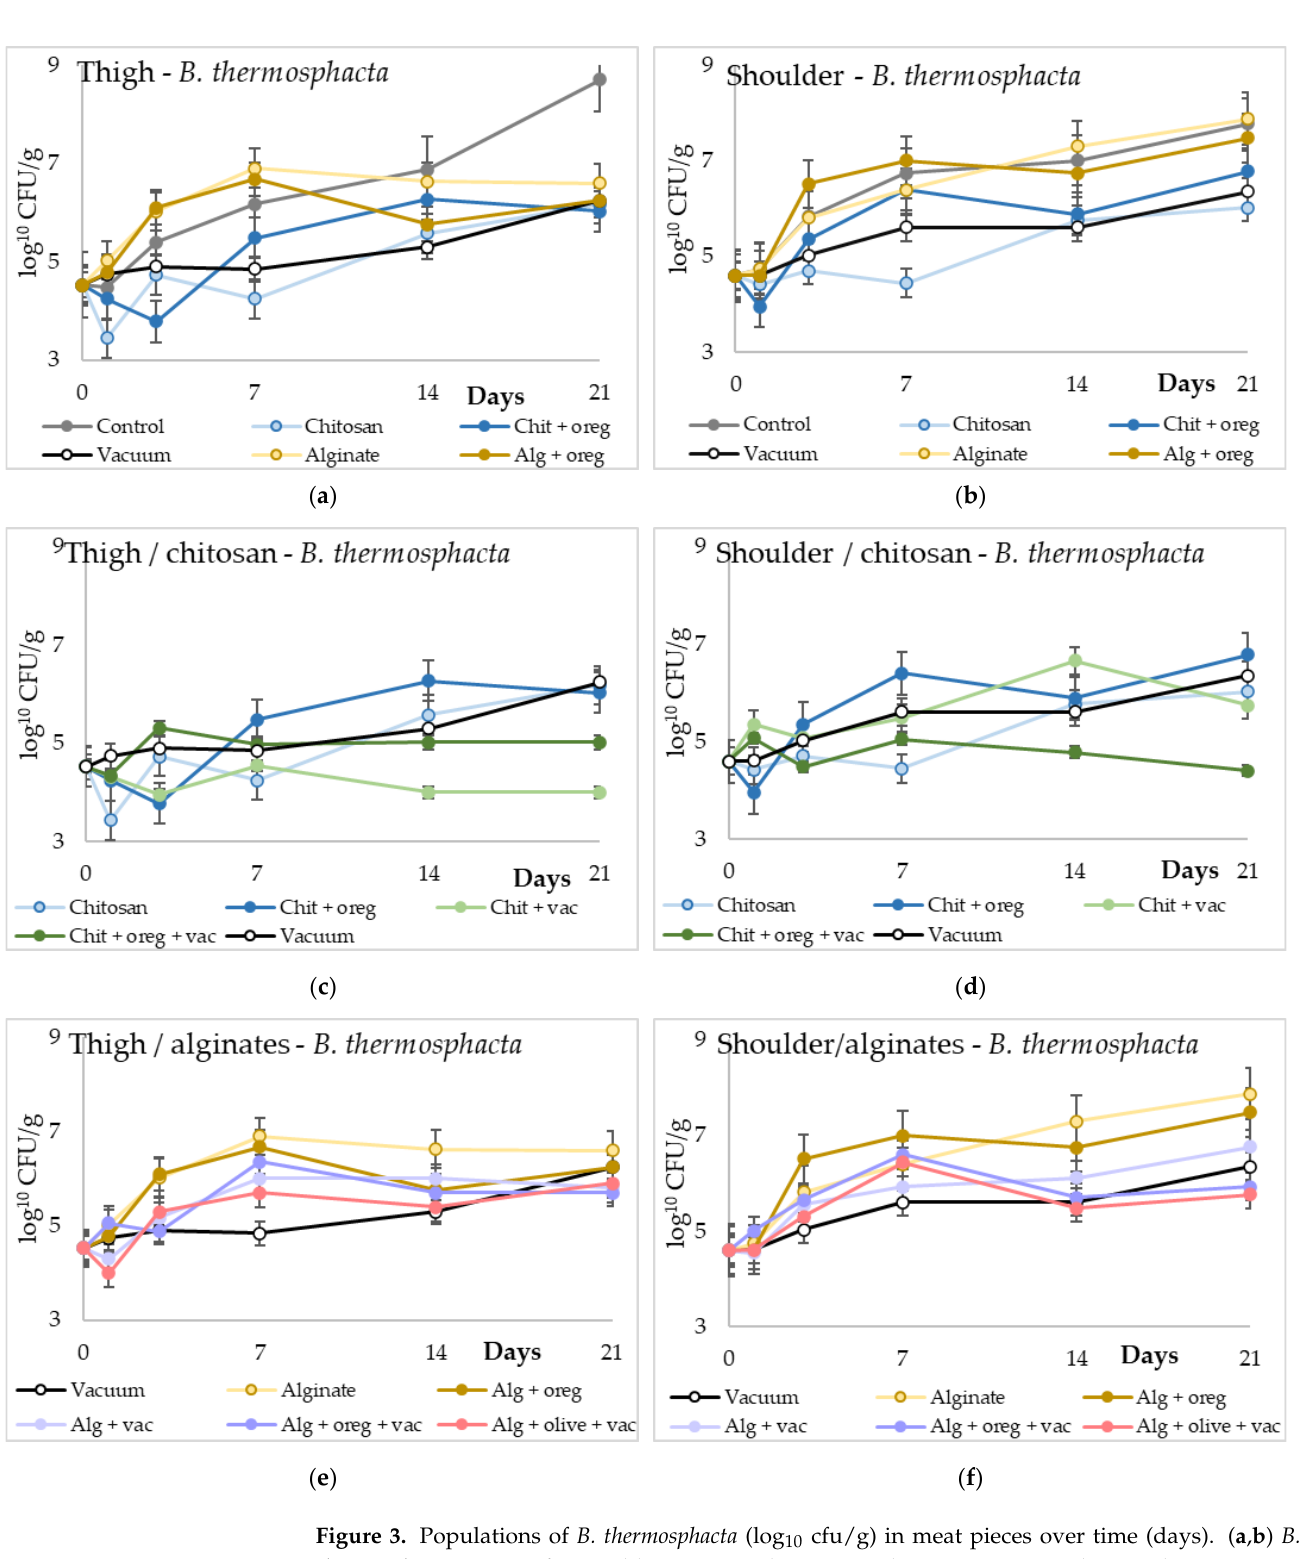
Figure 3. Populations of B. thermosphacta (log 10 cfu/g) in meat pieces over time (days). ( a , b ) B. thermosphacta counts of control lots against chitosan or alginate coating with or without vacuum packaging in thigh and shoulder pieces; ( c , d ) B. thermosphacta counts of different chitosan treatments in thigh and shoulder pieces; ( e , f ) B. thermosphacta counts of different alginate treatments in thigh and shoulder pieces. (Chit: chitosan coating; oreg: oregano essential oil; vac: vacuum packaging; Alg: alginate coating; olive: olive oil addition).